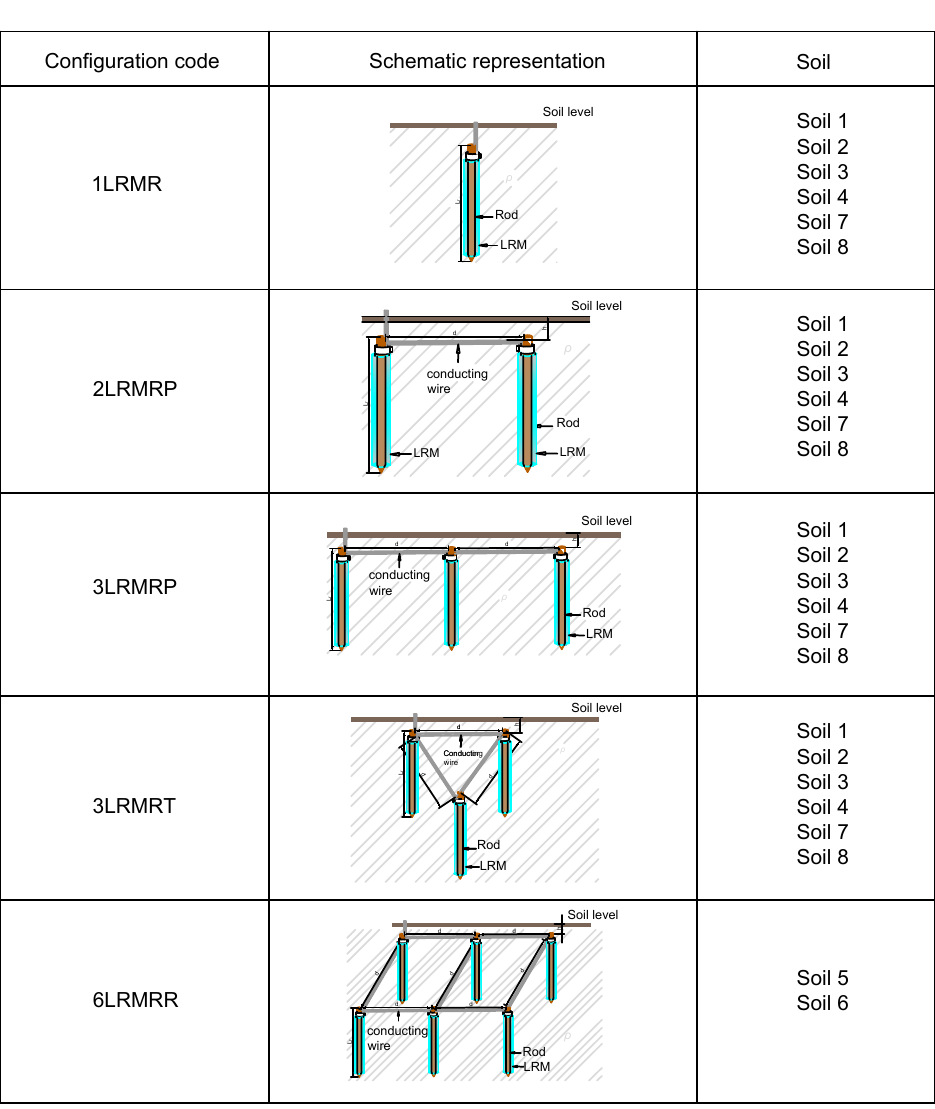
Figure 4. Basic GS designs with